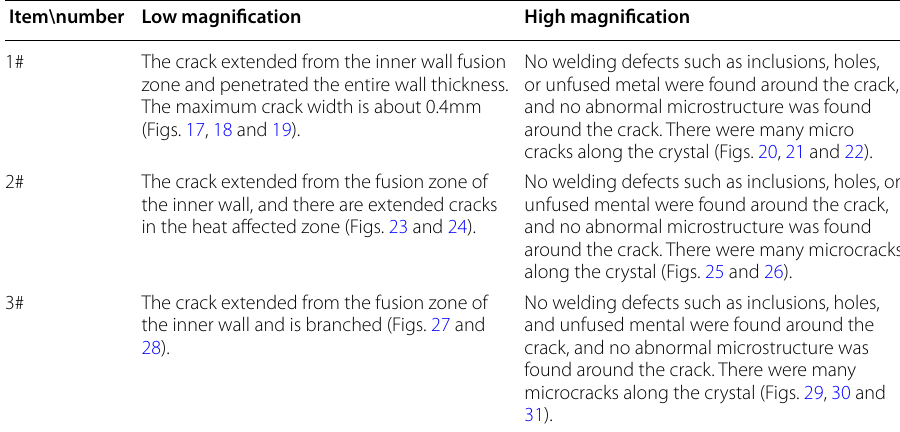
Table 12 Test results of weld crack position